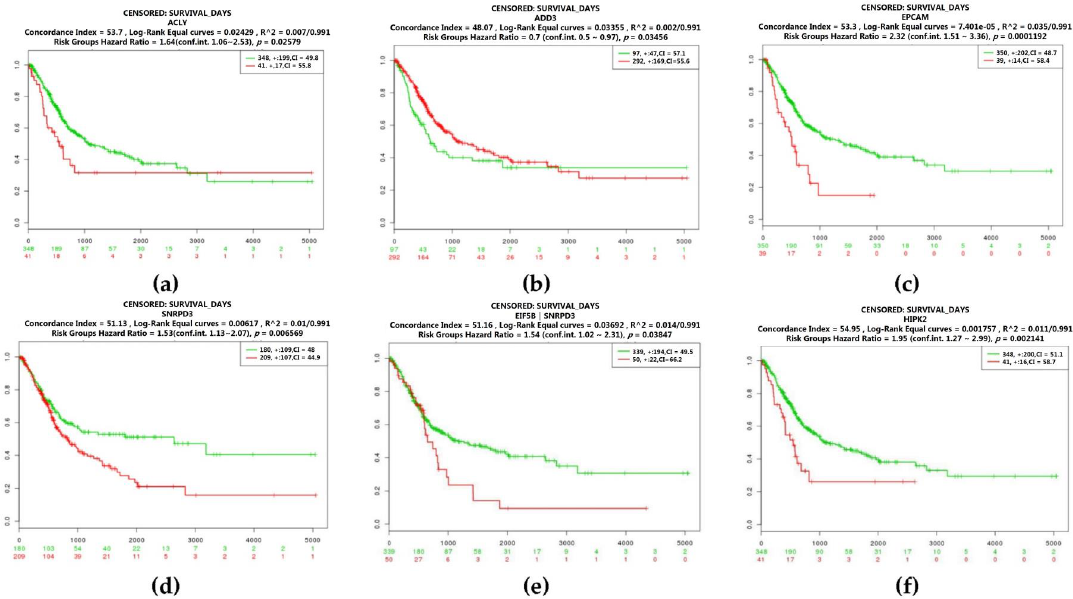
Figure 6. Overall survival of the hub genes in bladder cancer with human adenocarcinoma lymph node metastasis and transitional cell carcinoma lymphatic metastasis based on Kaplan–Meier plotter. The horizontal axis represents the time to event. The patients were stratified into the high-level group and low-level group and labeled with color. The red line indicates the samples with high risk, and the green line shows the samples with low risk. p < 0.05 is considered a statistically significant difference in mortality between the high-level group and low-level group. ( a )–( e ) Hub genes identified in human adenocarcinoma lymph node metastasis; (f) Hub genes identified in transitional cell carcinoma lymphatic metastasis. ( a ) ATP citrate lyase (ACLY); ( b ) Adducin 3 (ADD3); (c) epithelial cell adhesion molecule (EPCAM); ( d ) small nuclear ribonucleoprotein D3 polypeptide (SNRPD3); ( e ) Co-expression of EIF5B and SNRD3; (f) Homeodomain-interacting protein kinase 2 (HIPK2). Cancers 2020 , 12 , x